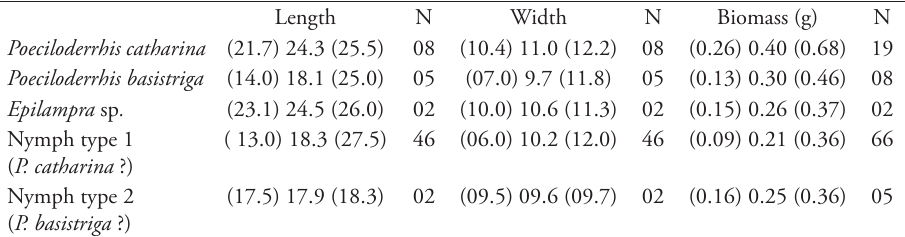
table 1. Length, width and biomass of prey species found in nests of Penepodium luteipenne (minimum, mean and maximum in